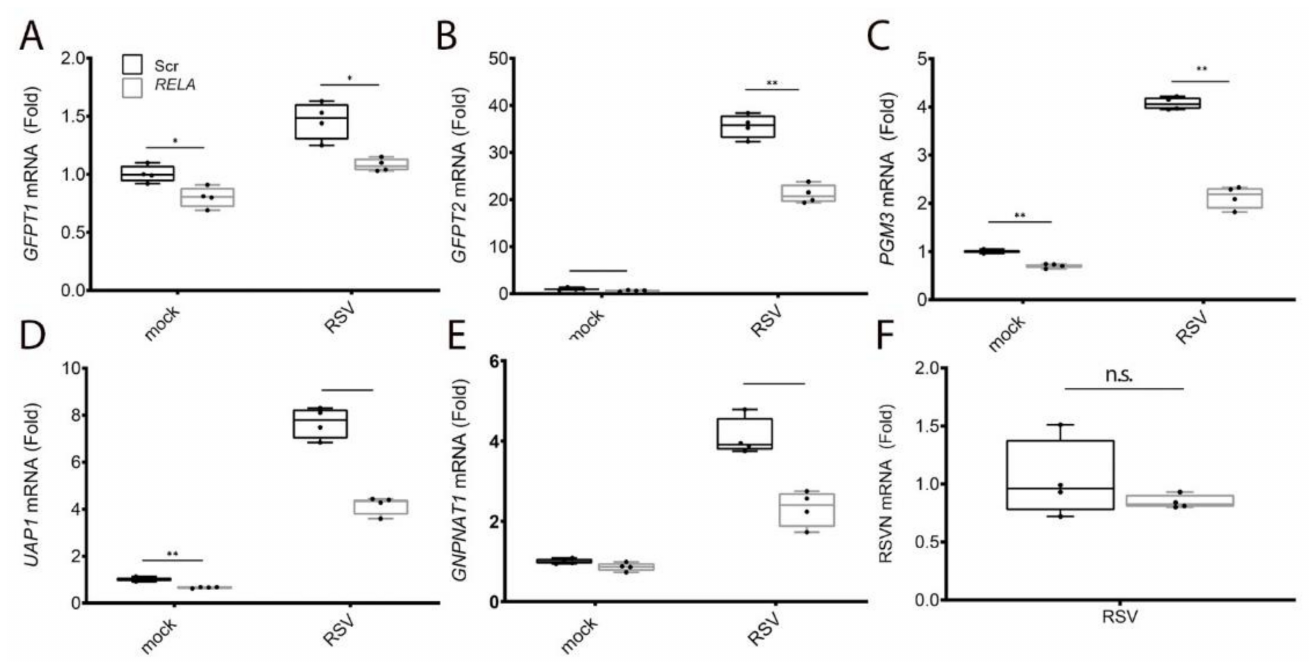
Figure 3. RELA coordinately activates expression of the HBP. Scrambled (Scr) or RELA-directed siRNA was transfected into hSAECs. Cells were mock-infected or RSV-infected (MOI = 1, 24 h) and qRT-PCR performed. Data are presented as fold change untreated controls normalized to peptidylpro- lyl isomerase A (PPIA) ( A ) GFPT1 mRNA, ( B ) GFPT2 mRNA, ( C ) PGM3 mRNA, ( D ) UAP1 mRNA, ( E ) GNPNAT1 mRNA. **, p < 0.01; *, p < 0.05, by post-hoc Tukey comparison. ( F ) Expression of RSV N transcript. n.s., not